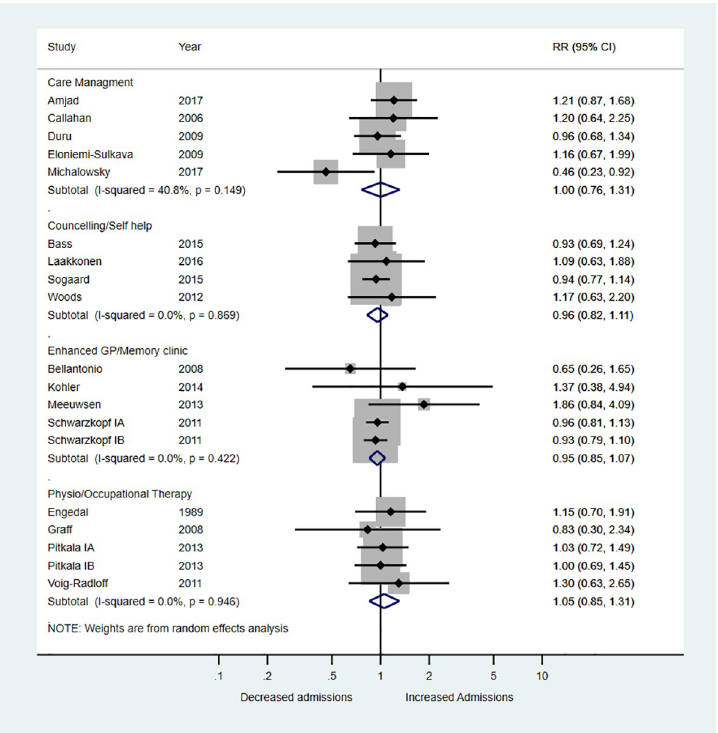
Fig 3. Forest plot of the relative risk (RR) of hospitalisation stratified according to type of intervention.